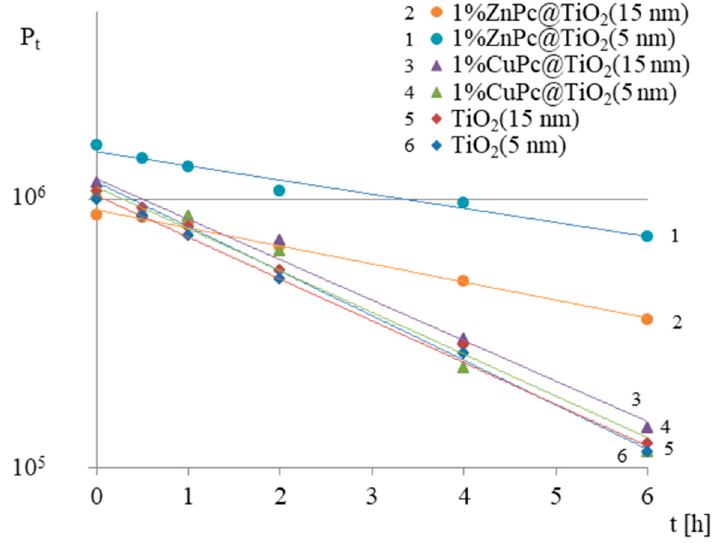
Figure 9. Comparison of ibuprofen ( IBU) decomposition rates under UV irradiation with different photocatalysts.